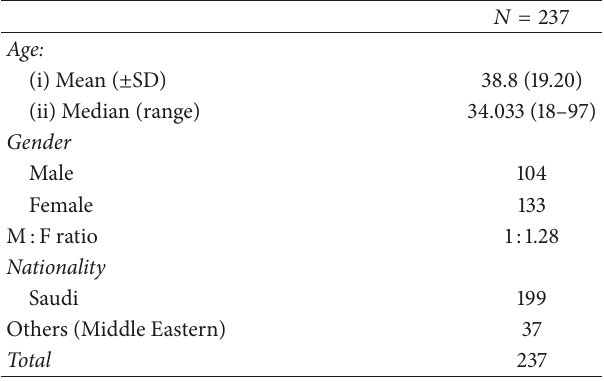
Table 1: Patient demographic data. Table 2: Biochemical profile of all patients.